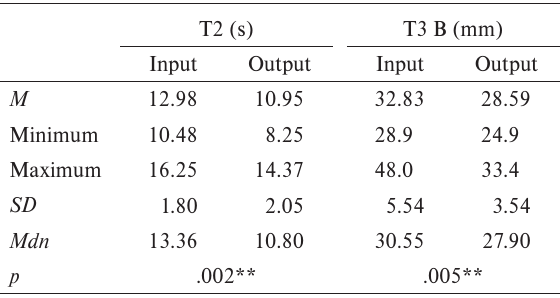
Dynamic balance in experimental group Dynamic balance in control